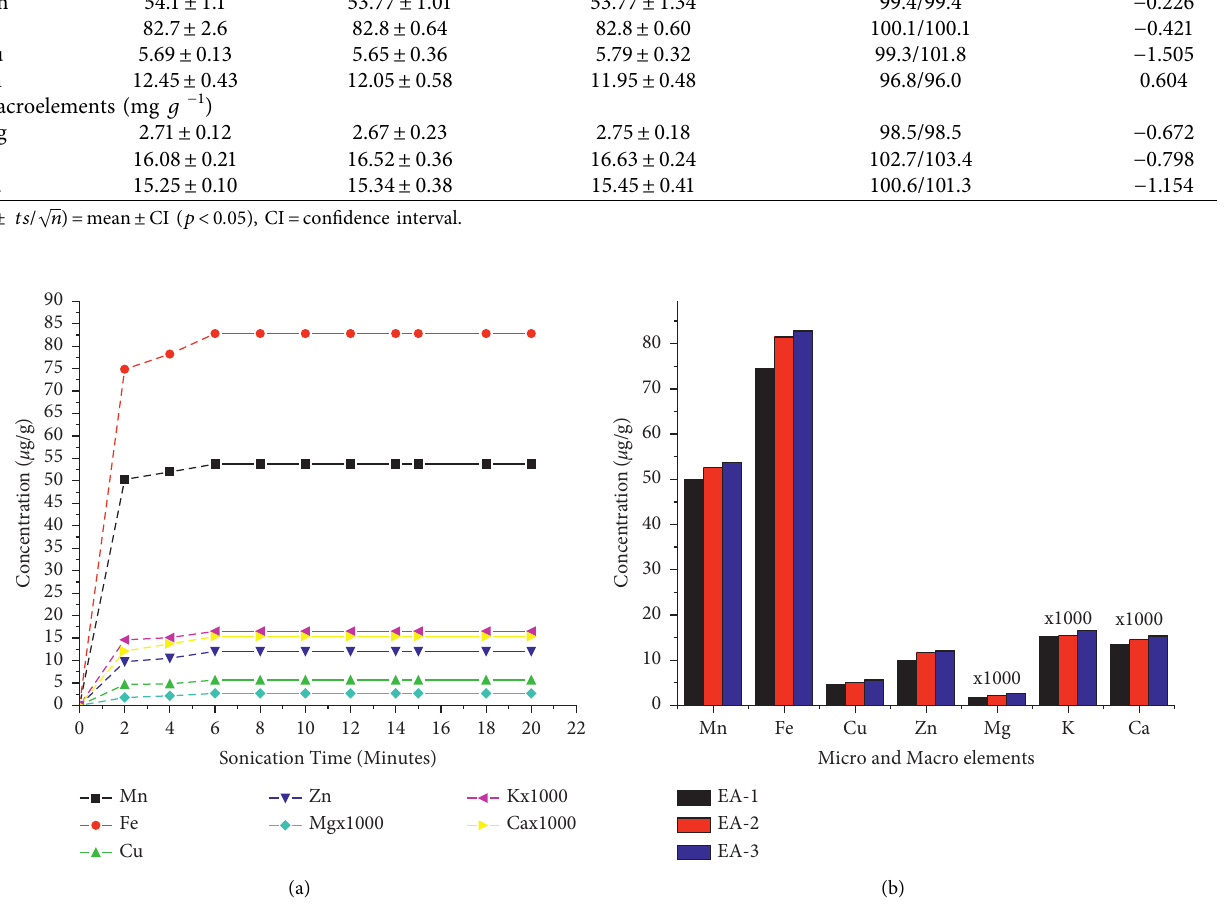
Figure 1: Sonication time (a) and extracting agent (b) influence on micro- and macroelements recovery from SRM (NIST 1515).